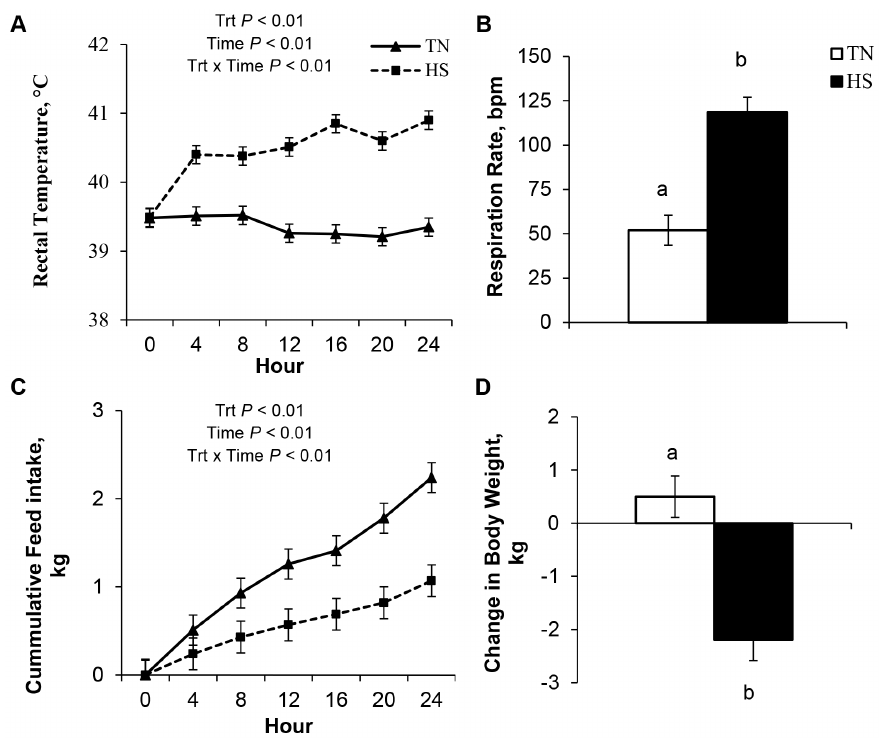
Figure 1. The effects of 24 hours of either constant thermal neutral conditions (TN; 21 u C) or heat stress conditions (HS; 35 u C) on a) rectal temperature, b) respiration rates, c) cumulative feed intake, and d) change in body weight in growing pigs. a,b P , 0.05, n=8/trt.